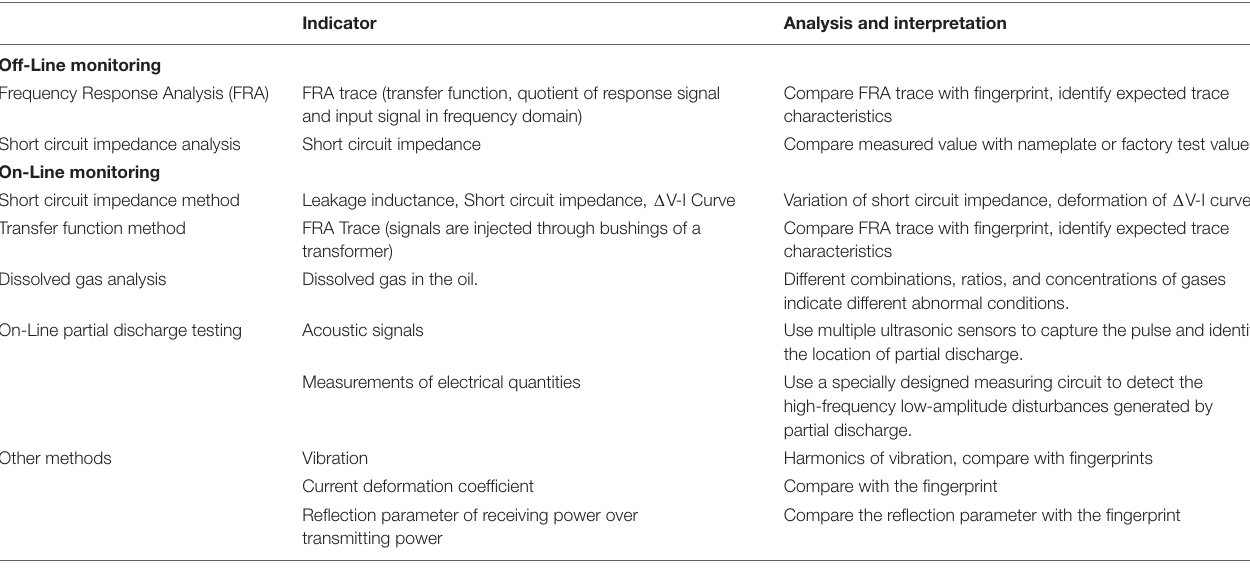
TABLE 2 | Summary of monitoring low frequency power transformers.